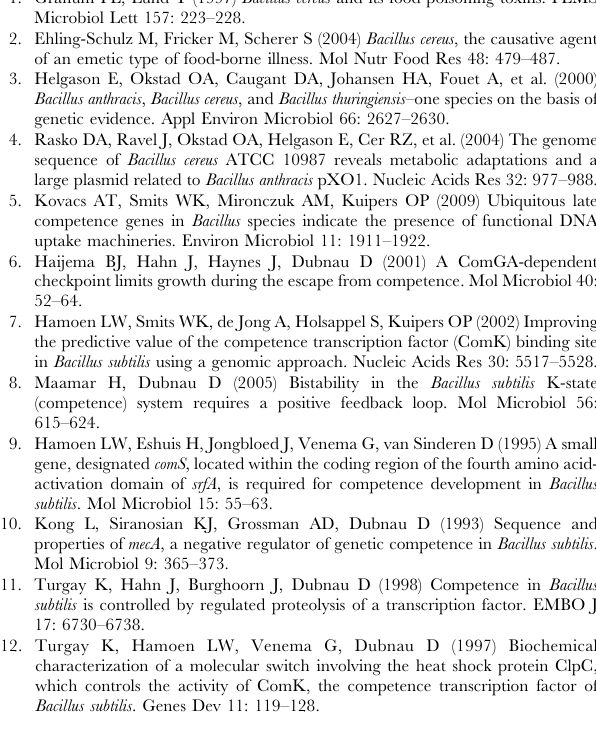
Figure S1 Level of green fluorescent protein (gfp) in B.